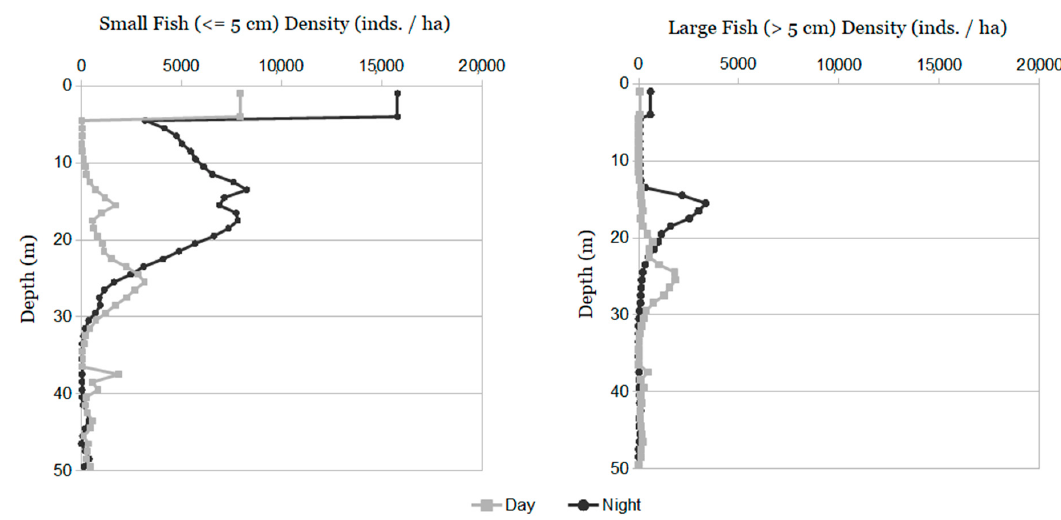
Figure 13. Vertical distribution of density (inds. / ha) of the detected target size classes (small: < 5 cm, 13 large: 5–50 cm) during the day and night surveys in Lake